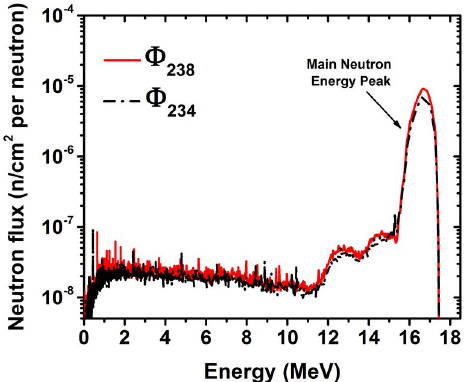
Figure 4. The neutron flux with respect to the neutron energy, as obtained from the MCNP5 simulation for the irradiation at 16.5 MeV neutron energy.